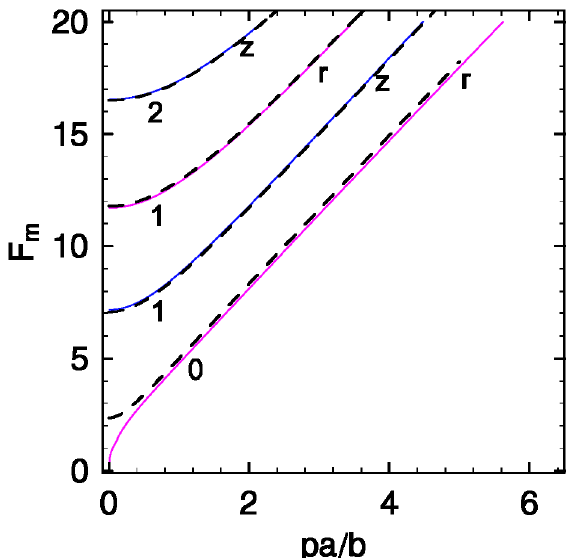
FIG. 2. (Color) Solution of the dispersion equation (cid:10) (cid:1) 0 for various mode numbers m indicated on the plot. E magenta (also indicated by symbol r ); E by symbol z ). The dashed lines show the approximate solutions discussed in the subsection of